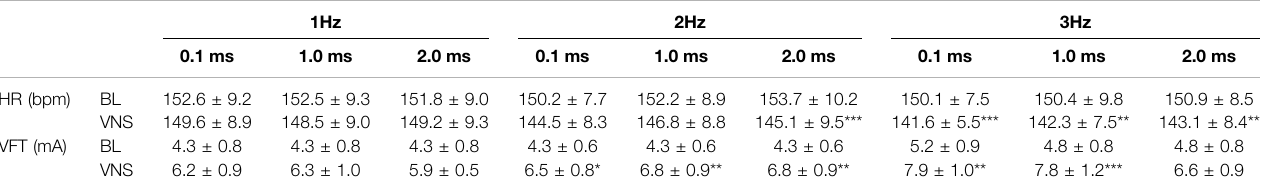
TABLE 3| Theeffects oflowvoltageand lowfrequencyVNSonHRandVFT. HRchangesfrombaseline (BL)toVNSat1(A),2(B)and 3 Hz(C)atstimulation pulsewidthsof 0.1,1and2 ms.VFTchangesfrombaseline(BL)toVNSat1(D),2(E)and3 Hz(F)atstimulationpulsewidthsof0.1,1and2 ms.Datarepresentmean±SEM.* p < 0.05, ** p < 0.01, *** p < 0.001 vs. corresponding BL, n =